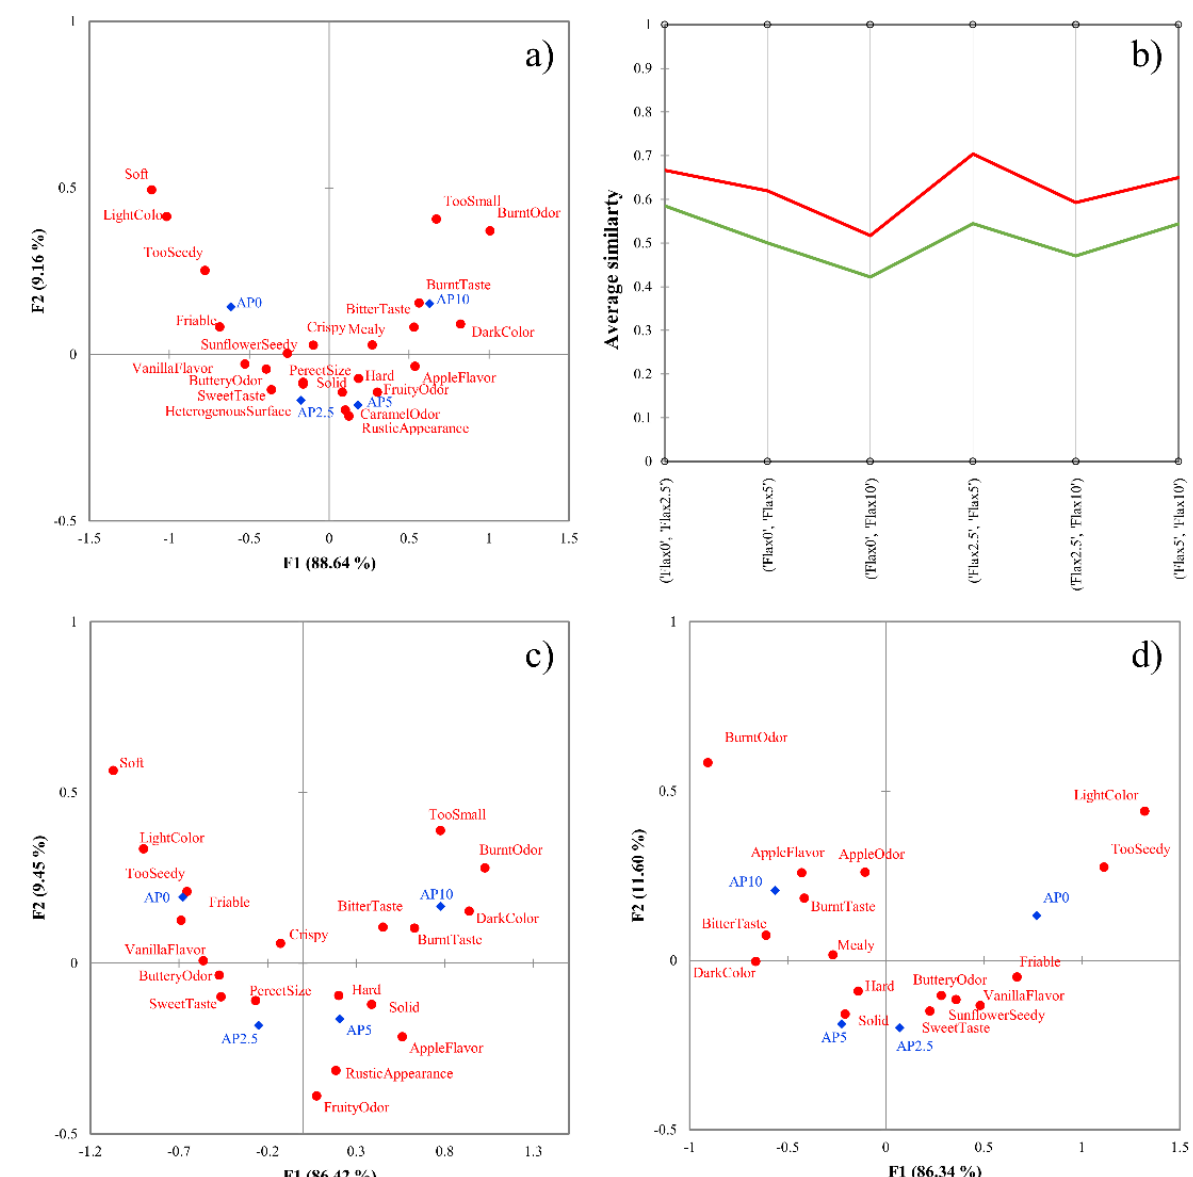
Figure 4. ( a – d ) Results of the apple pomace-enriched biscuit dataset. Correspondence analysis of the total sample (n = 60). ( a ), profile plot of the agglomerative hierarchical cluster analysis with Euclidean distance and Ward’s method ( b ), correspondence analysis of good discriminators (n = 37) ( c ), correspondence analysis of poor discriminators (n = 23) ( d ). Products are marked with blue dots, attributes are marked with red squares in panels ( a , c , d ), cluster of good discriminators is colored by green, while poor discriminators are colored by red in panel ( b ). Samples contained 0% (AP0), 2.5% (AP2.5), 5% (AP5), and 10% (AP10) ground apple pomace.